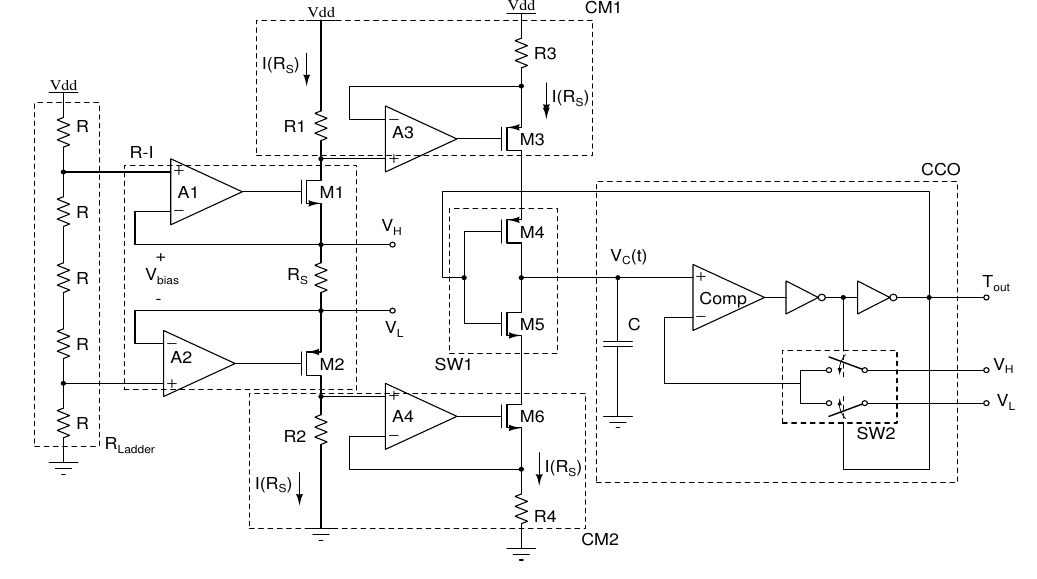
Figure 6. The proposed